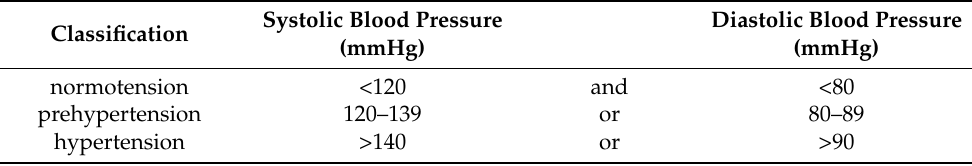
Table 1. Blood pressure classification according to